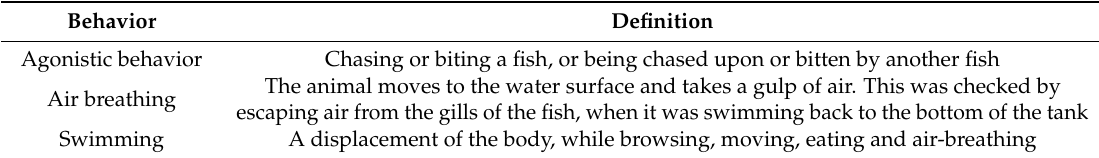
Table 7. Ethogram—behavioral patterns and their definition, adapted from van de Nieuwegiessen et al. [53].